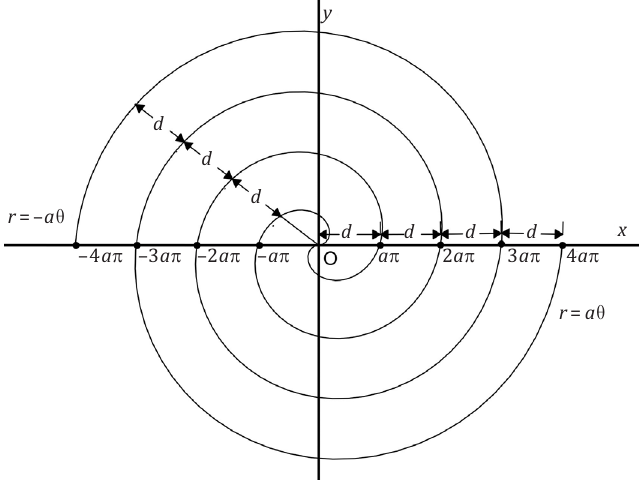
Figure 6. The combination of spirals r = a q and r = – a q for 0 < q < 4